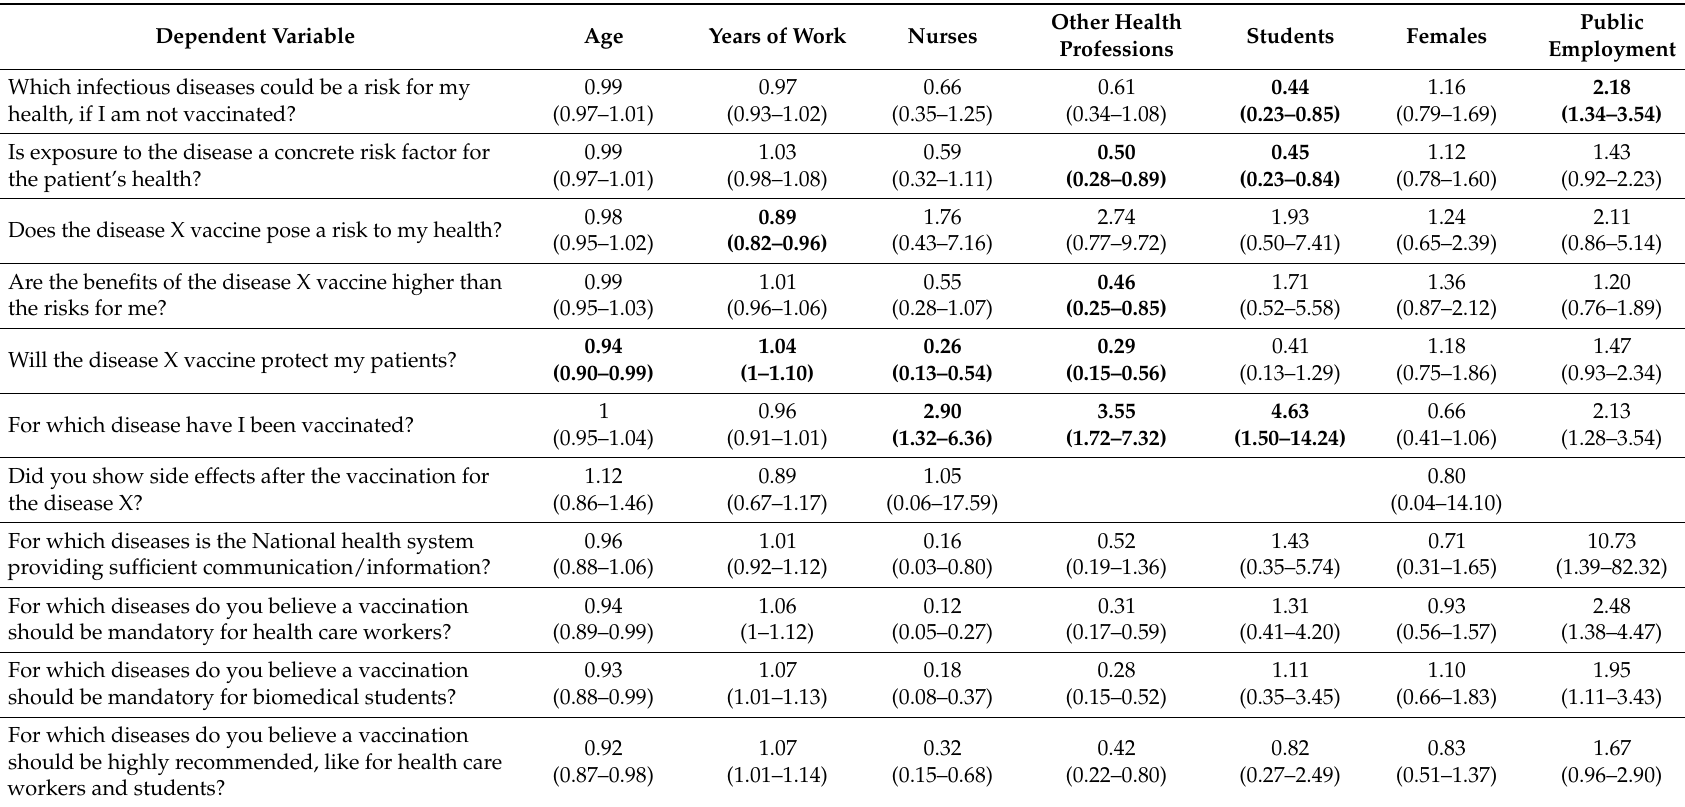
Table 6. Results of the multivariate analysis considering